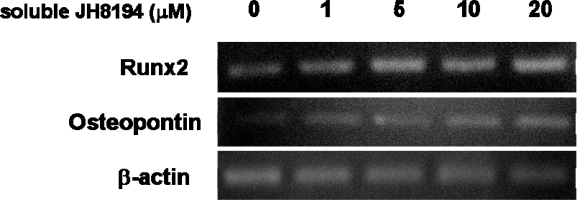
The effects of soluble JH8194 on the osteoblastic gene expressions were analyzed by RT-PCR. In the culture system, the cells were inoculated (day-0) and then reached at confluence in three days (day-3). By the two different types of duration of soluble JH8194, the alteration of the osteoblast-differentiation markers in MC3T3-E1 loaded with soluble JH8194 was analyzed. Concretely, the first pattern of soluble JH8194-duration was that soluble JH8194 was added to the cells on day-0 just after inoculation of the cells, followed by that the cells were successively cultured for seven days. The other one was that the exposure of soluble JH8194 to the cells, for the first time, started, when the cells became confluent (day-3). The cells were cultured, totally during seven days including the period until confluence. The addition of soluble JH8194 was done once until RNA isolation in both patterns in JH8194-duration. Total RNA was extracted from each cell to analyze the expression levels of Runx2 and OPN mRNA. Data are representative of three experiments.